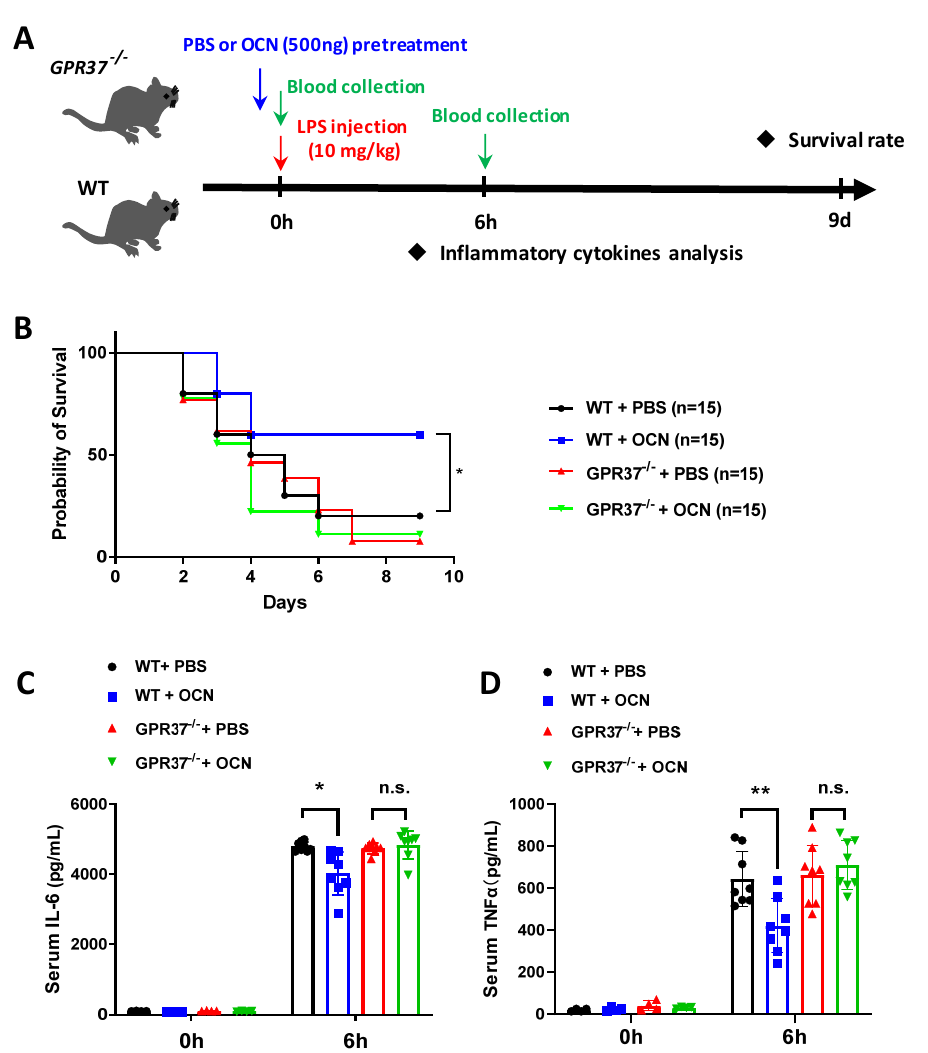
Figure 6. The protective function of OCN against LPS is absent in GPR37 − / − mice. ( A ) Experimental design for LPS-induced acute inflammation in GPR37 − / − and WT mice. After intraperitoneal injection of PBS or OCN (500 ng), followed by LPS (10 mg/kg) treatment, mice survival rate and serum inflammatory cytokine level were analyzed accordingly. ( B ) Survival curves of GPR37 − / − and WT mice treated with PBS or OCN in response to an LPS challenge. Sample sizes are presented in brackets ( n = 15). * p < 0.05, as compared to PBS. ( C , D ) After 6h of LPS injection, with or without OCN pretreatment, serum IL-6 ( C ) and TNF α ( D ) levels were analyzed in GPR37 − / − and WT mice. Sample sizes are indicated as dots in columns. * p < 0.05 and ** p < 0.01, as compared to PBS; n.s. indicates not significant.